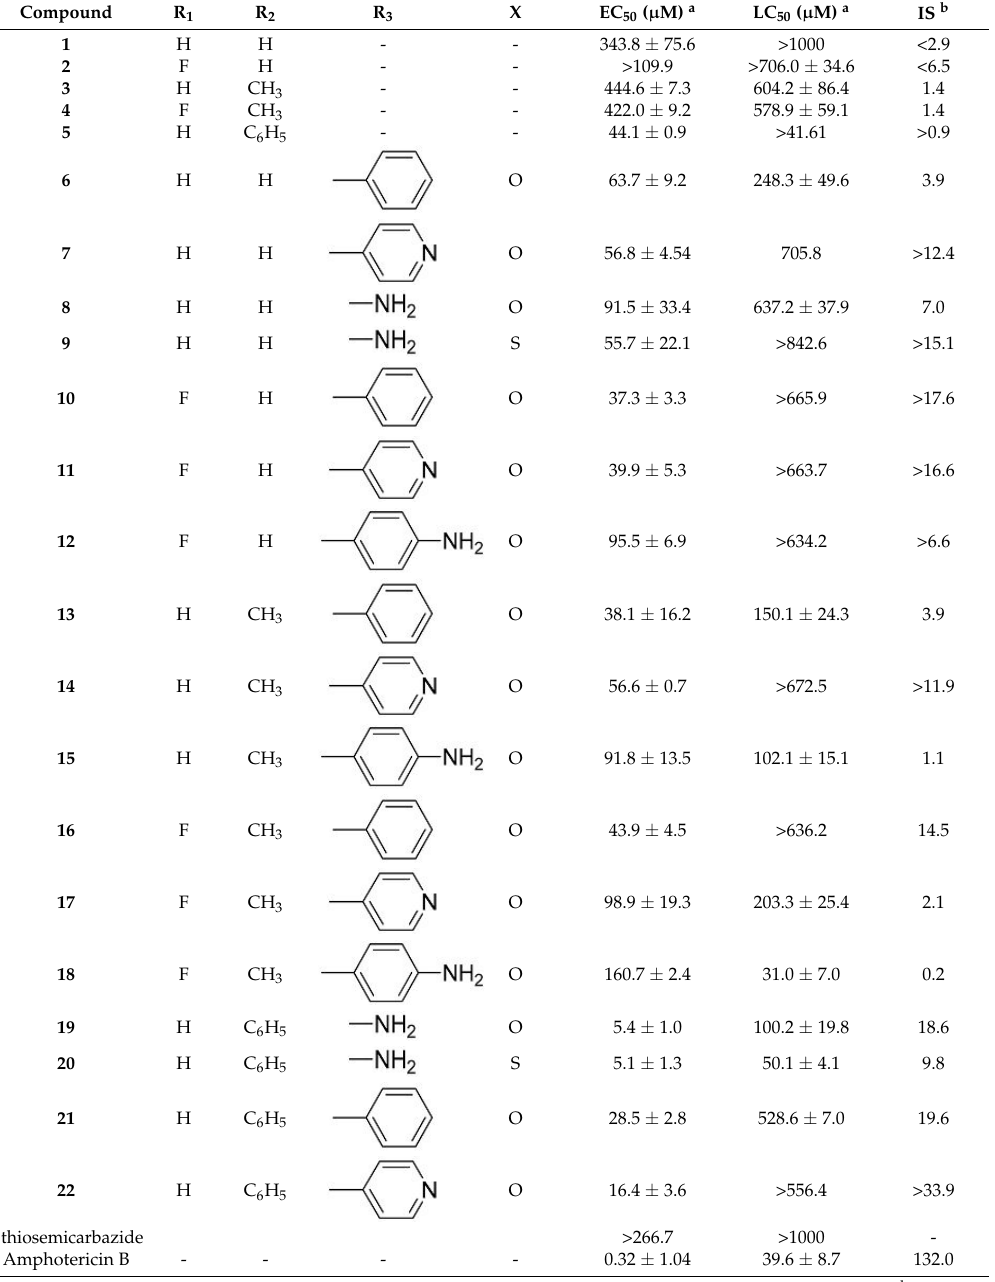
Table 1. In vitro antileishmanial and cytotoxic